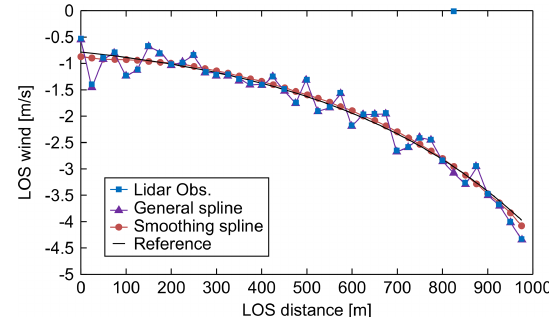
Figure 17. LOS wind values: measured data with error and noise, reference wind, smoothing spline, and general